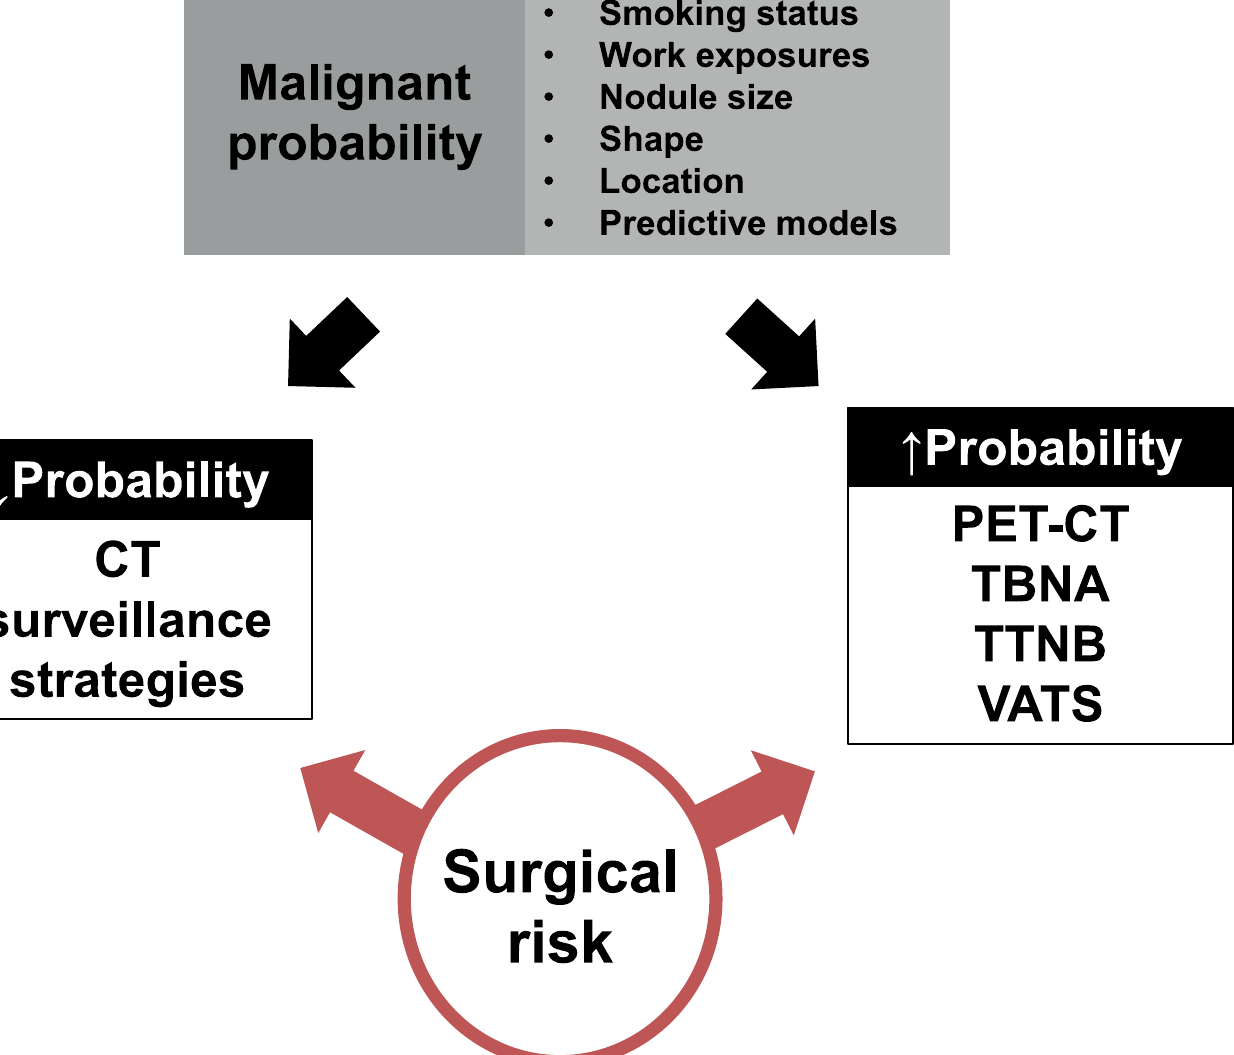
Fig 1. Diagnostic strategies for incidentally discovered solitary pulmonary nodules (adapted from: Gould et al.